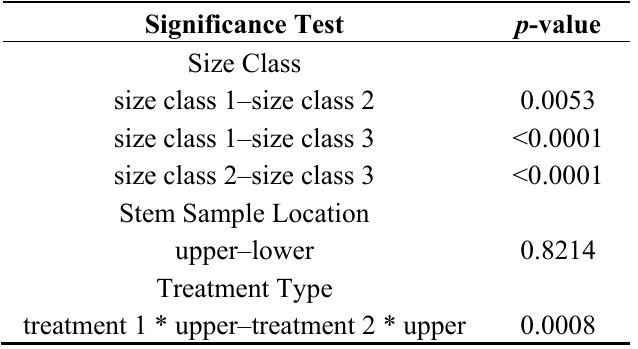
Table 3. Results of Tukey’s HSD test to determine ad hoc differences in bole moisture content between size classes, stem sample location, and treatment type.